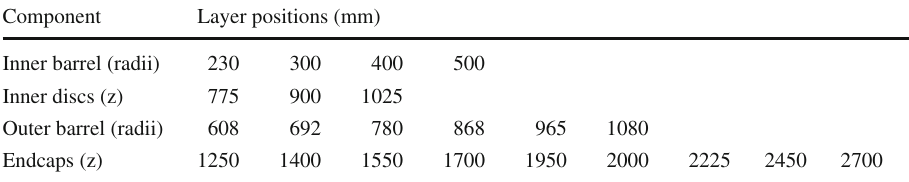
Table 2 Locations used for the layers in the CMS